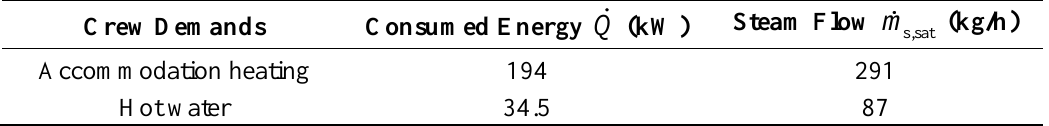
Table 2. Shipwide heat consumption for crew demands [28].